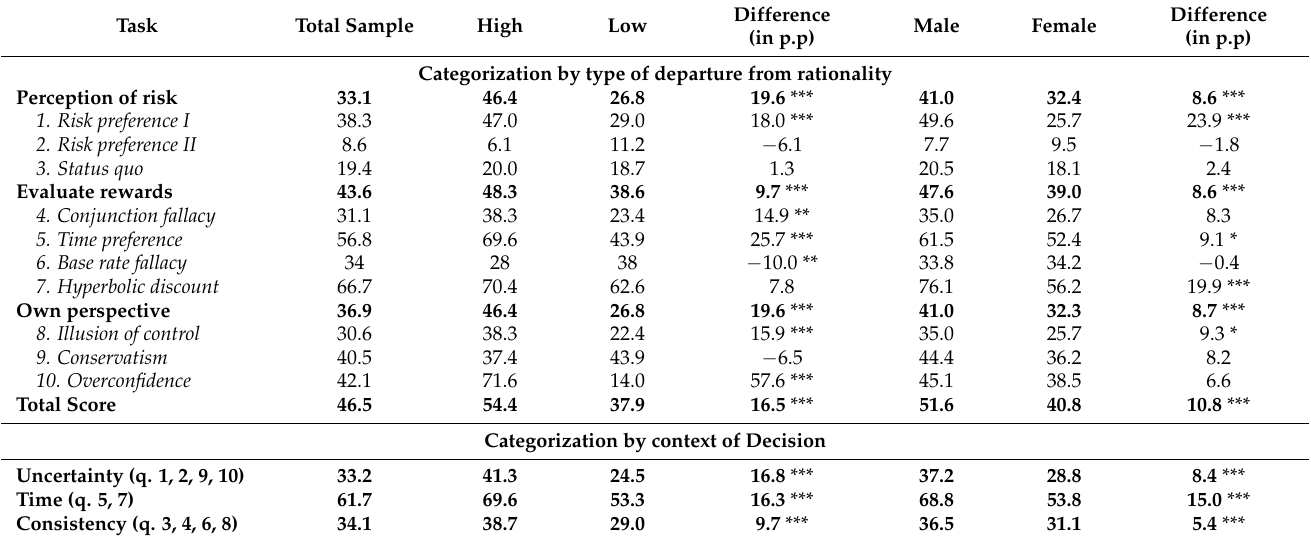
Table 2. Conformity to REM (heuristic and bias tasks) by CRT group and gender (% of correct